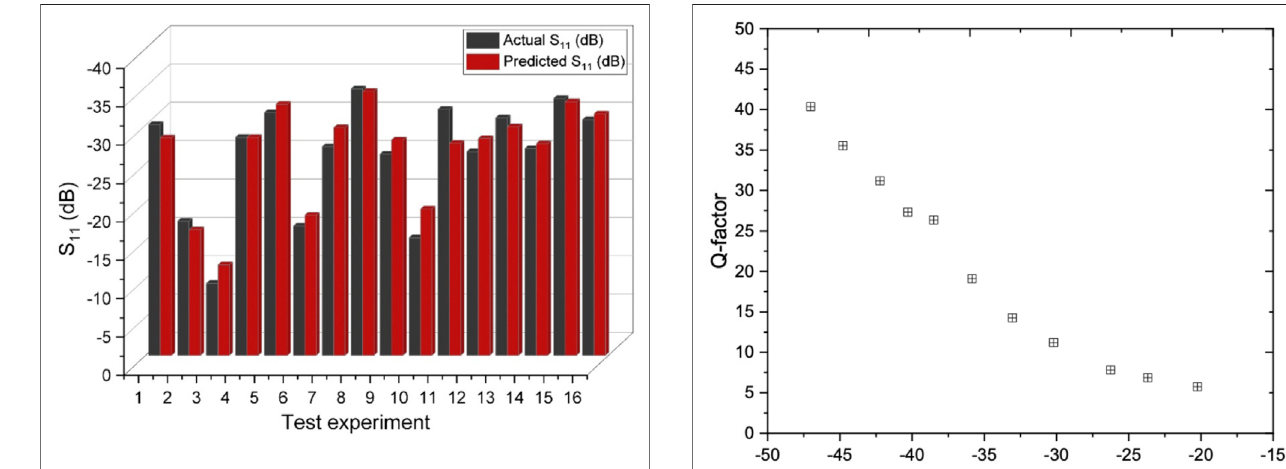
FIGURE7| Thecomparisonofactualandpredictedre fl ectioncoef fi cient values for different experiments.